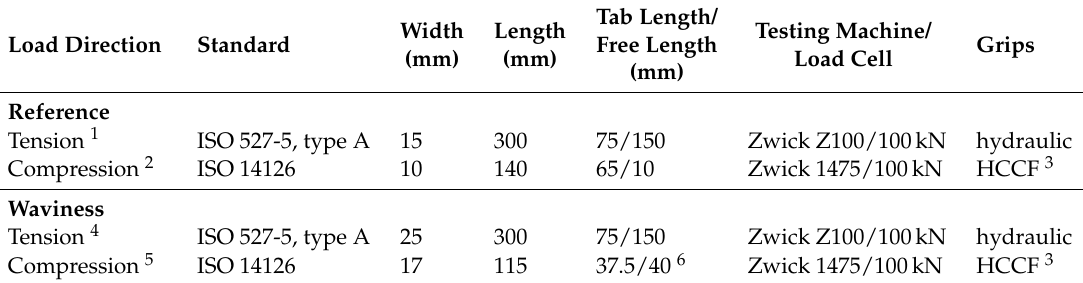
Table 7. Standards and specimen dimensions for material testing in fiber direction of reference samples and samples with imposed